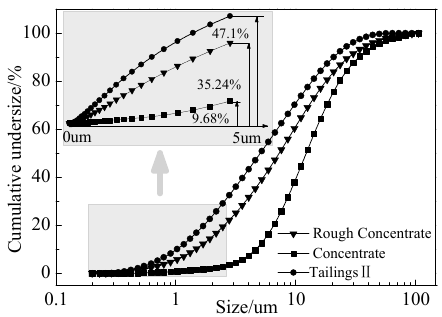
Figure 5. The particle size distributions of products.